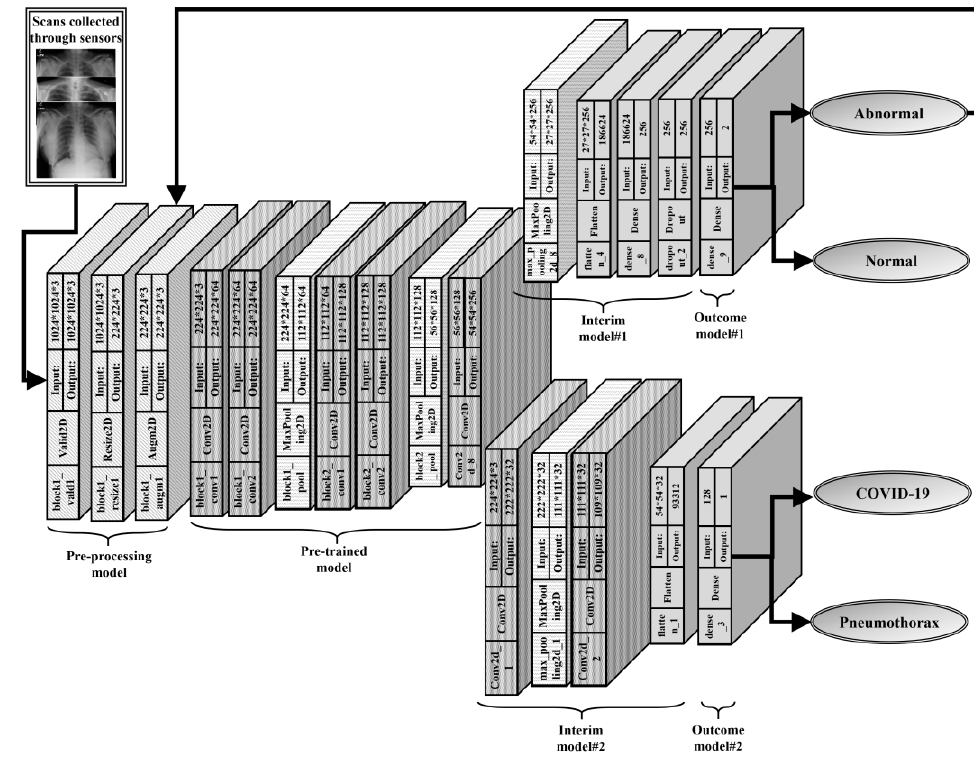
Figure 1. Proposed Model.